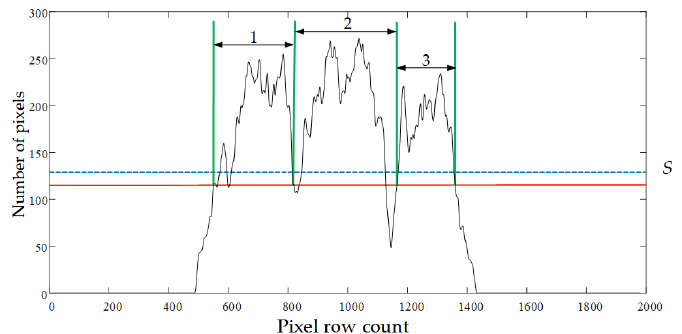
Figure 8. Target areas scanned on the projection histogram. The end positions (blue line) and the final scan line position (red line).